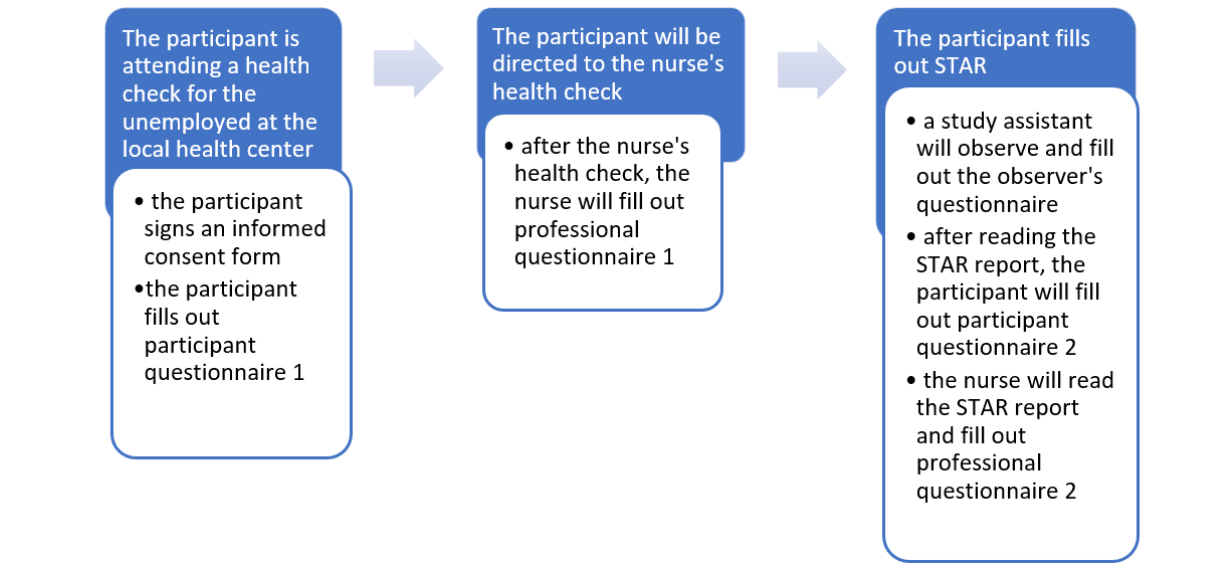
Figure 2. Counterbalanced